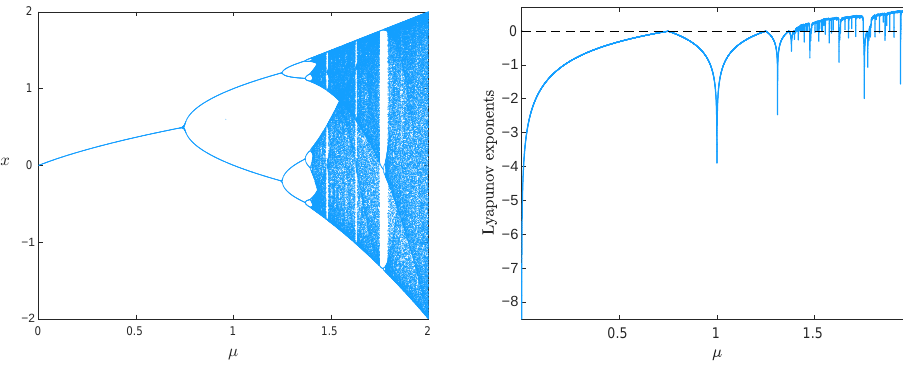
Figure 2. The bifurcation diagram of the quadratic map ( left ), and its Lyapunov exponents ( right